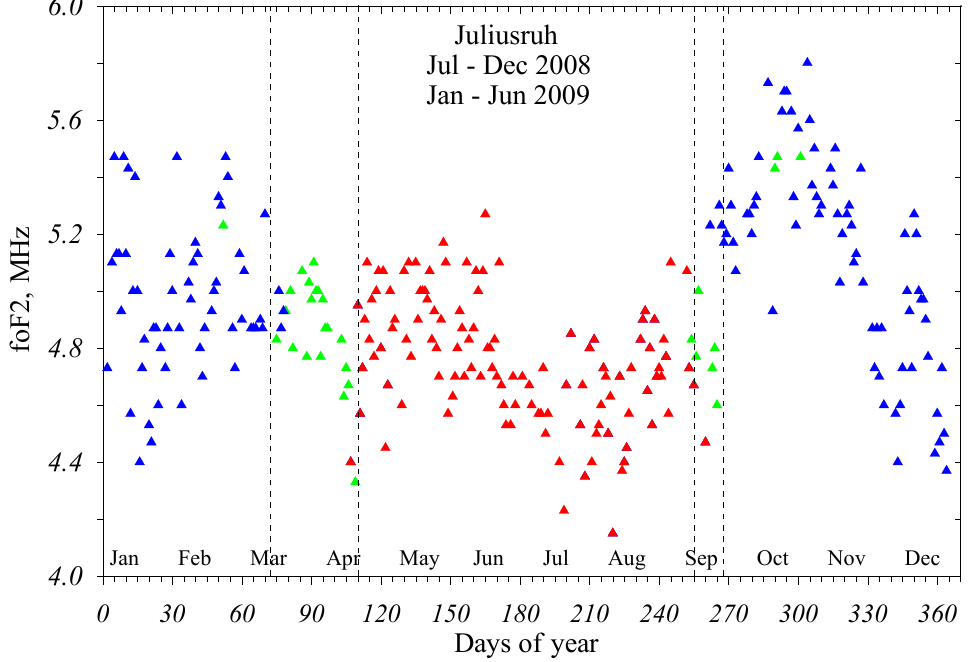
Figure 3. Seasonal distribution of days with three types of foF 2 diurnal variation at Juliusruh during July–December 2008 and January–June 2009. Noontime foF 2 values are given. Blue triangles—days with winter type of foF 2 diurnal variation, red triangles—summer type, and green triangles—equinoctial type. Vertical dashed lines con fi ne the periods of equinoctial transition.